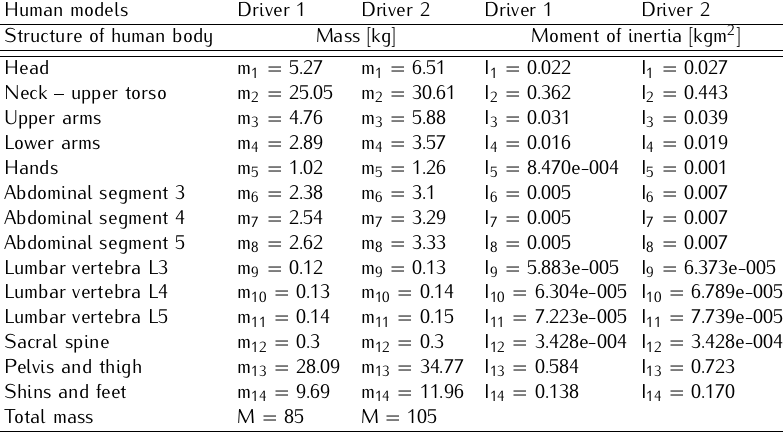
Table 2. Layout of the human body mass and moments of inertia for two models of drivers.